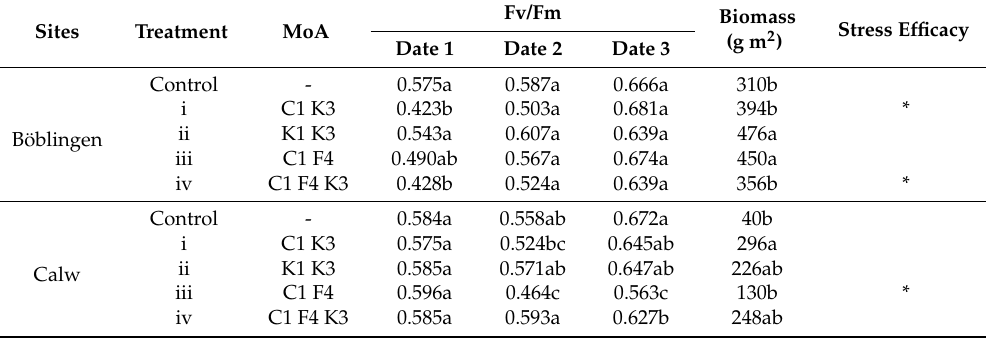
Table 3. The results of chlorophyll fluorescence (means of Fv/Fm values) and dry biomass measurements of the field experiment. MoA, Mode of Action; C1, Inhibition of PS II; F4, Inhibition of DOXP synthase; K1, Inhibition of microtubule assembly; K3, Inhibition of cell division (VLCFA); *, stress efficacy indicated by significantly different Fv/Fm values and biomass in both measurements; significant differences between mean values are indicated by different letters (Tukey’s HSD Test, p < 0.05).